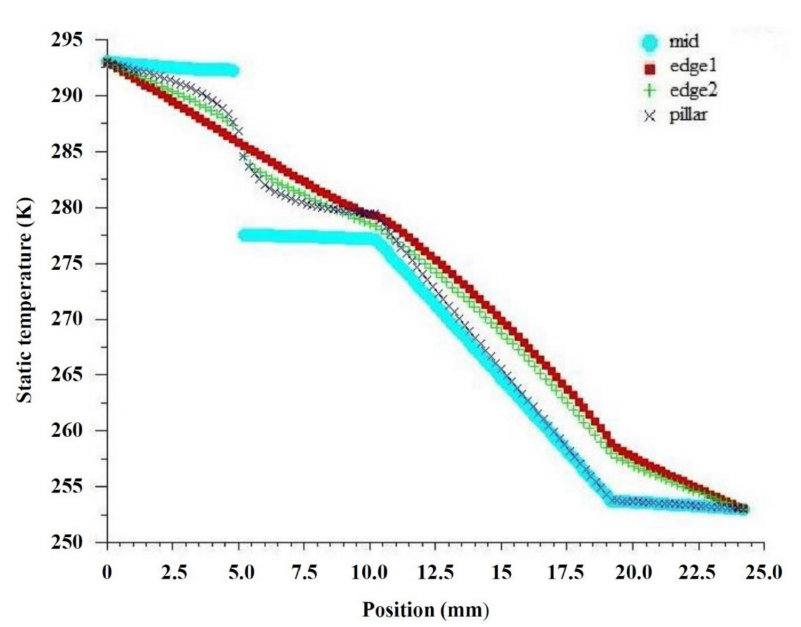
Figure 8. Temperature curve of CVG (NLC scenario) along the thickness direction.